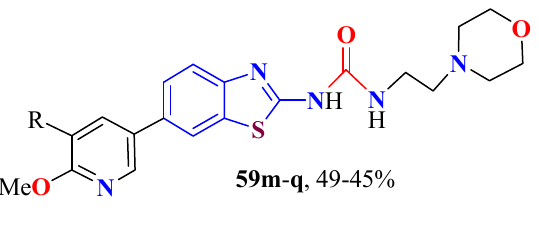
Figure 10. In the case of pyridine ring 59m , the activity dramatically dropped.